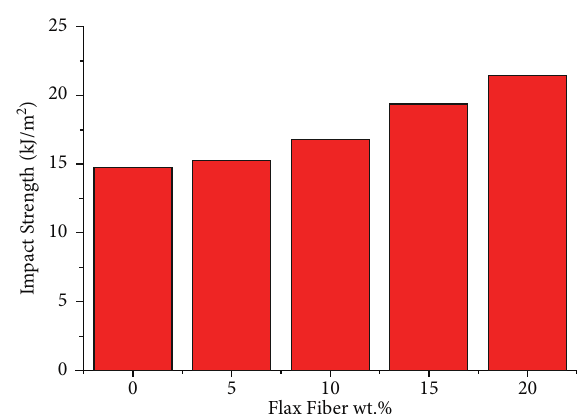
Figure 9: Effect of flax fibre content on impact strength of pure and hybrid composites.